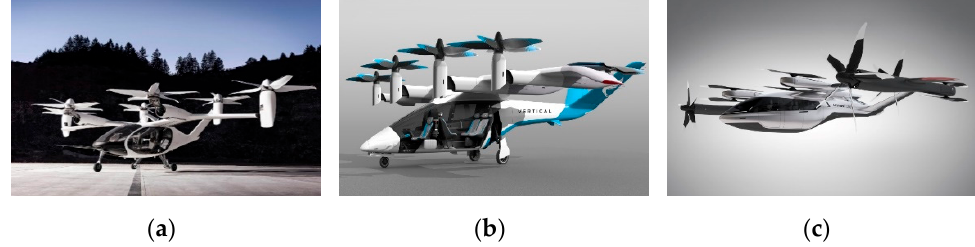
Figure 1. Various eVTOL aircraft with the multi-rotor system [2]: ( a ) Joby S4 (Joby Aviation); ( b ) VA-X4 (Vertical Aerospace); ( c ) S-A1 (Hyundai Motors).